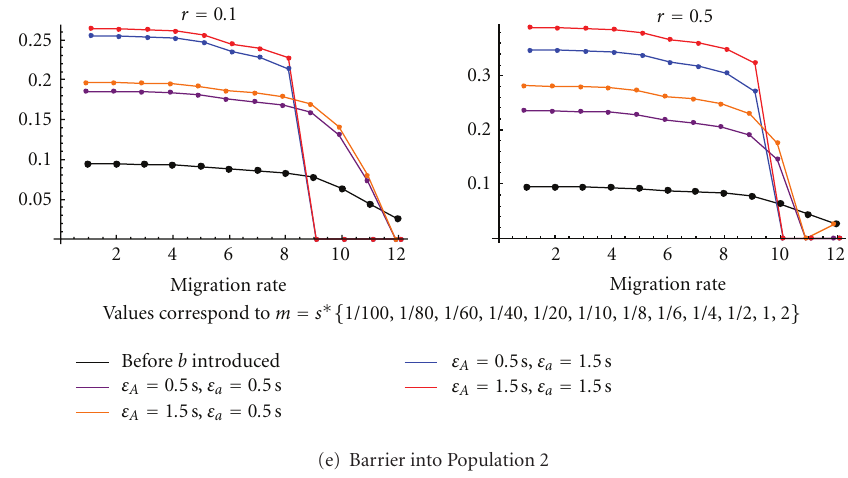
Figure 3: Numerical simulation results for the model with modifier with both epistatic trade-o ff and direct, divergent selection (Case2, full model). Parameter values used: s = s 1 = s 2 = 0 . 1; t 1 = t 2 = 0 . 5 s . See Figure 2 for other